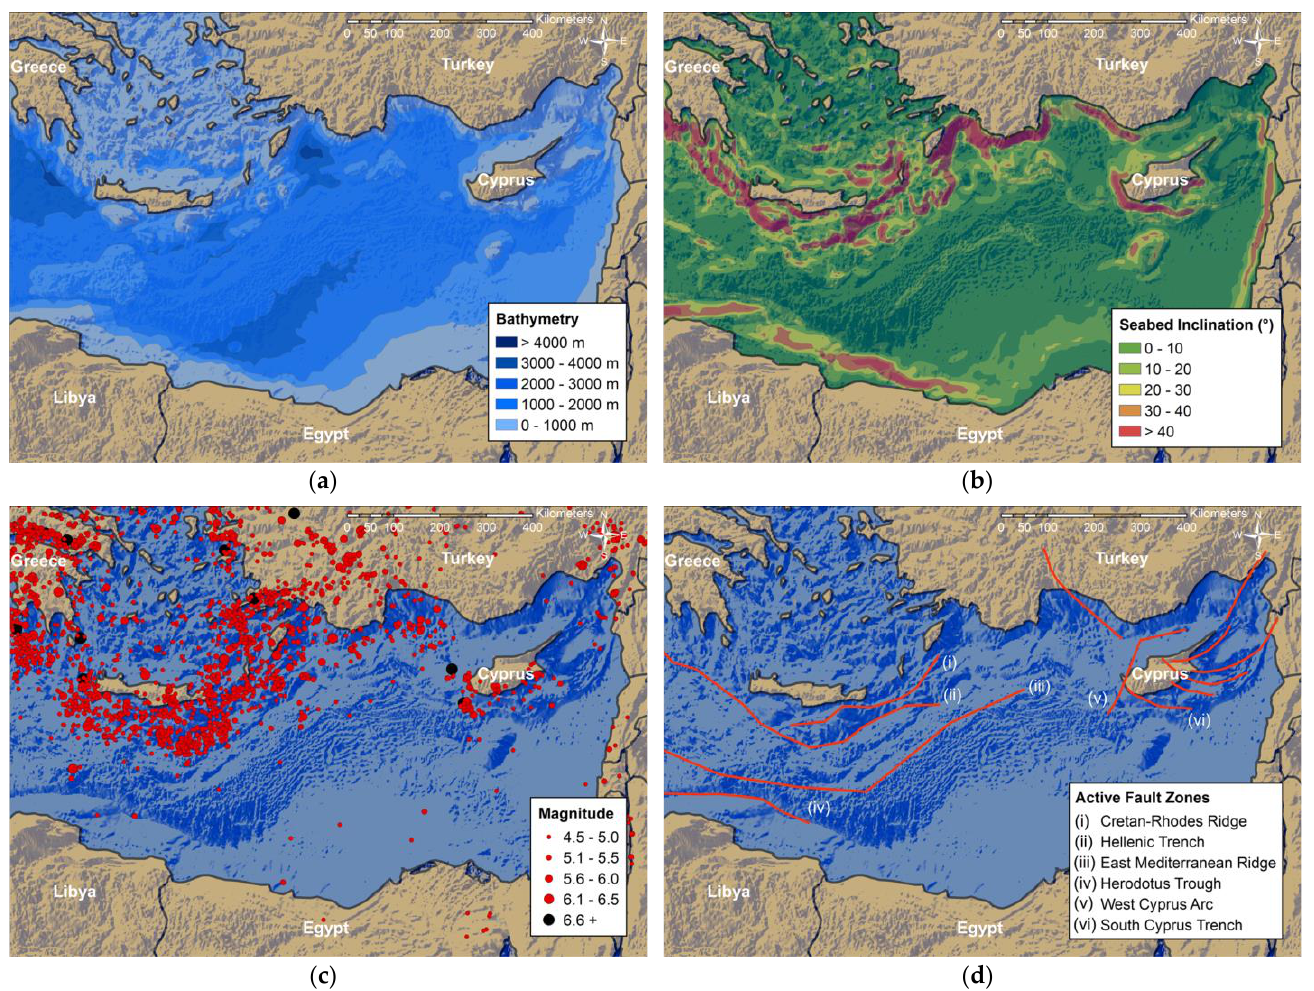
Figure 7. Geodata of the area under consideration for the application of the smart decision-support tool: ( a ) bathymetry, ( b ) seabed inclination, ( c ) seismicity and ( d ) major seismically active fault zones.